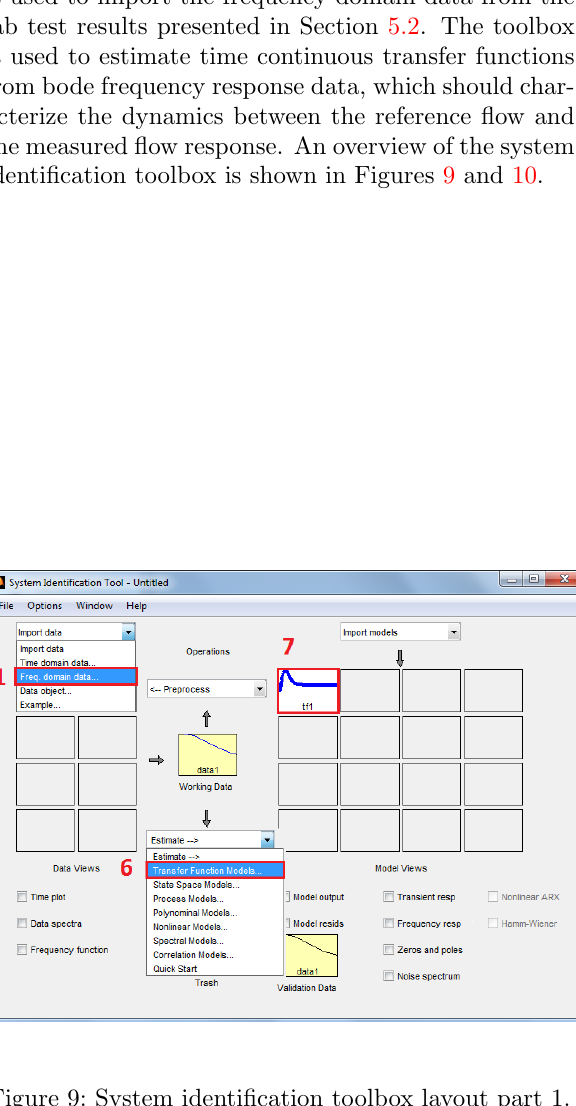
Figure 9: System identification toolbox layout part 1.